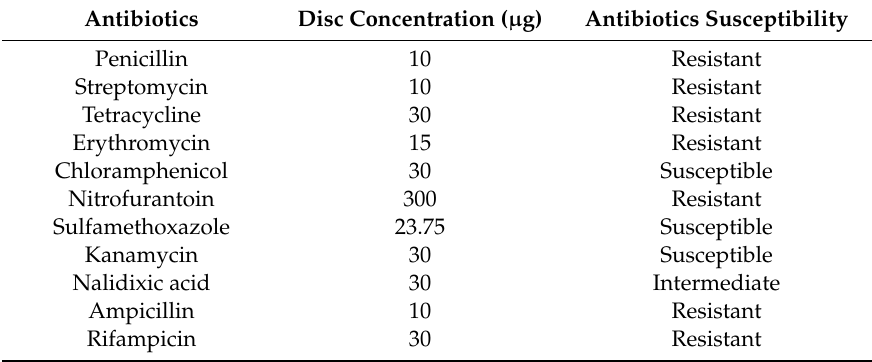
Table 2. The list of antibiotics and susceptibility tested for Stenotrophomonas sp. strain MA5. Antibiotics Disc Concentration ( µ g) Antibiotics Susceptibility Penicillin 10 Resistant Streptomycin 10 Resistant Tetracycline 30 Resistant Erythromycin 15 Resistant Chloramphenicol 30 Susceptible 300 Resistant Sulfamethoxazole 23.75 Susceptible Kanamycin